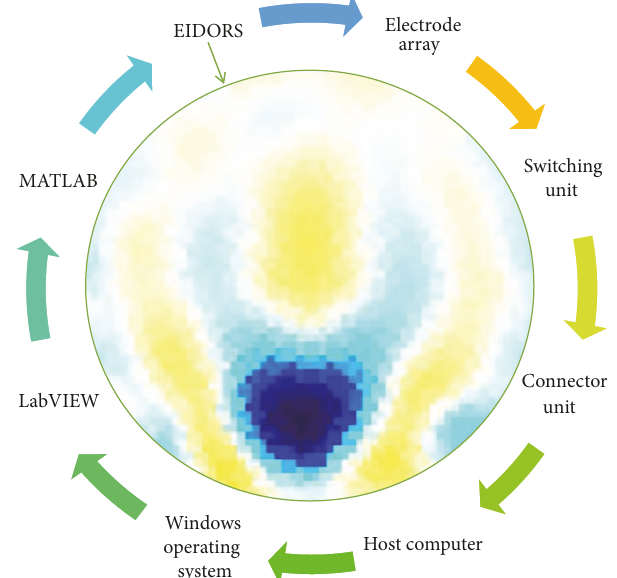
Figure 3: UNMC EIT system operational sequence cycle.